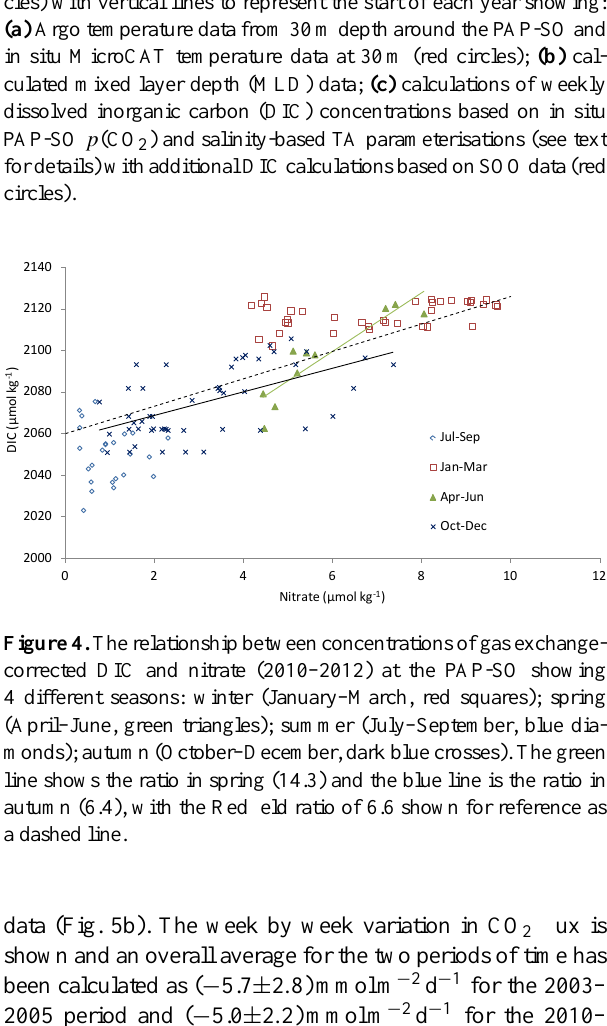
data (Fig. 5b). The week by week variation in CO 2 flux is shown and an overall average for the two periods of time has been calculated as ( − 5.7 ± 2 . 8) mmolm − 2 d − 1 for the 2003– 2005 period and ( − 5.0 ± 2 . 2) mmolm − 2 d − 1 for the 2010– 2012 period. SOO data have been used at the start of